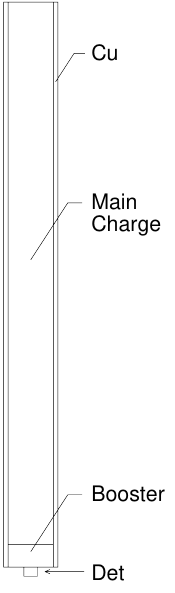
Figure 8. Notional addembly with no aluminum plates.